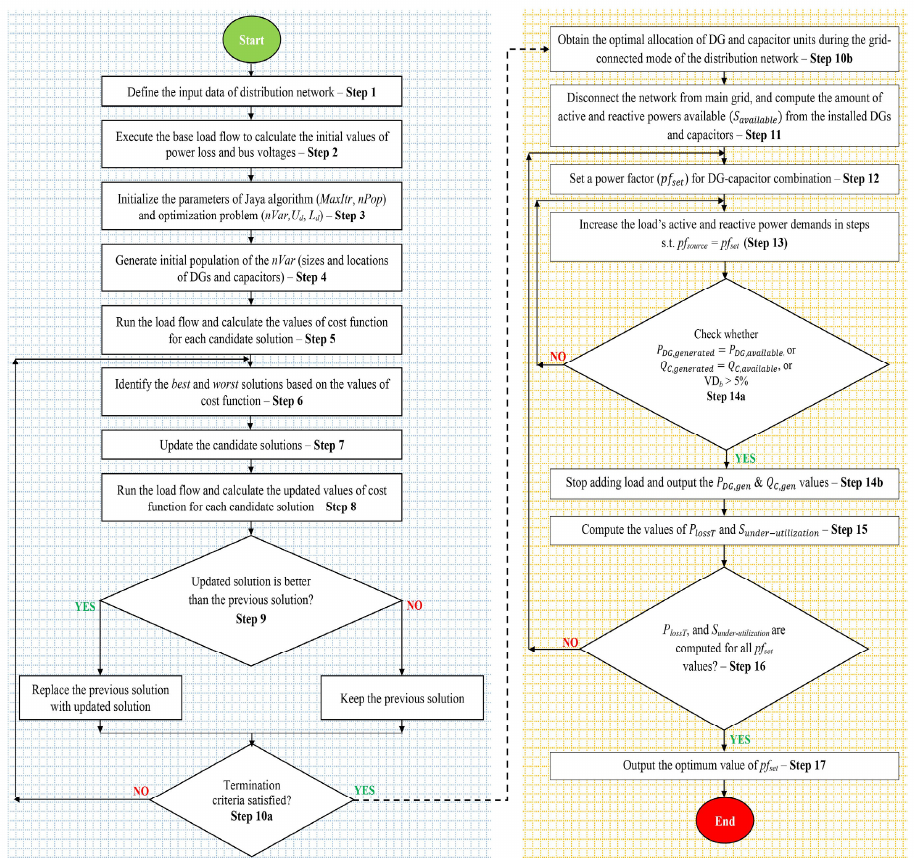
Figure 5. The proposed methodology to efficiently utilize the mounted distributed sources in islanded distribution networks under the power mismatch condition.